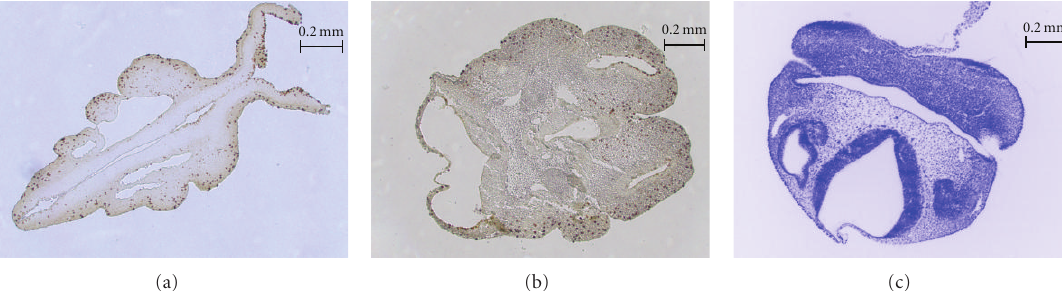
Figure 1: Mouse embryo head tissue samples considered in our study. (a) and (b) show dark-stained nuclei of proliferating cells, whereas (c) shows nuclei of proliferating cells stained to fluoresce under UV light (background inverted to white for viewing